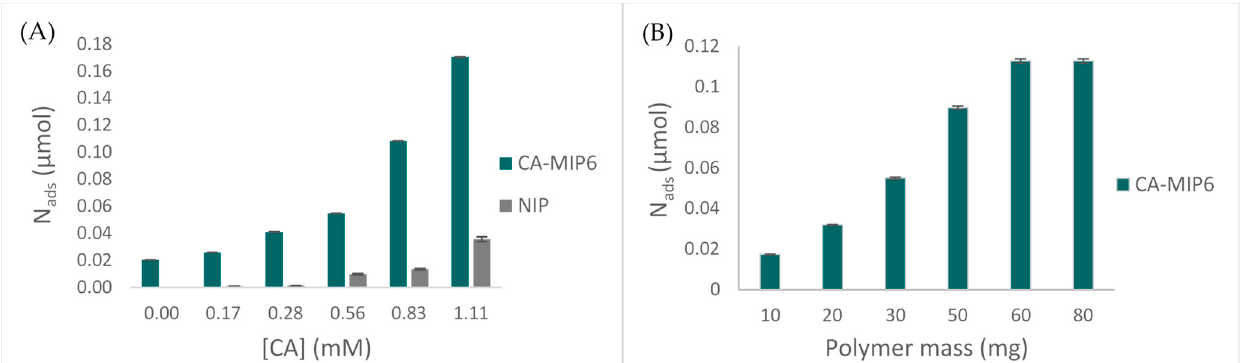
Figure 6. Rebinding properties of MIP6 in spiked wine: ( A ) N ads of CA (µmol) in the function of the initial concentration, m of the polymer = 10 mg. ( B ) N ads of CA (µmol) in the function of the polymer mass, initial CA concentration = 0.056 mM.